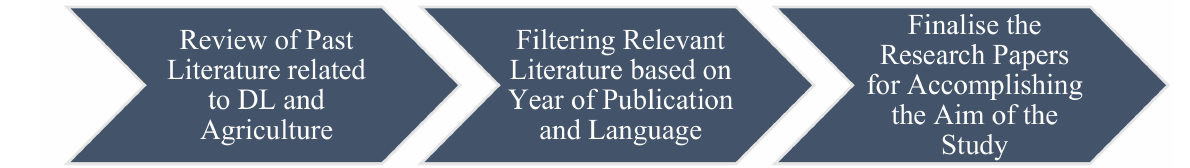
Figure 1. The research